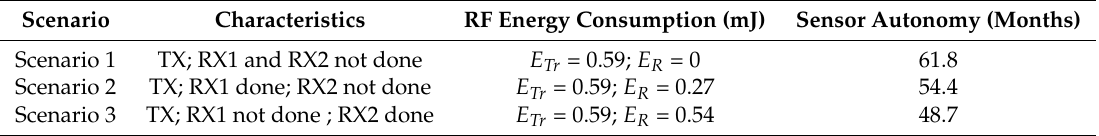
Table 7. Comparison between different